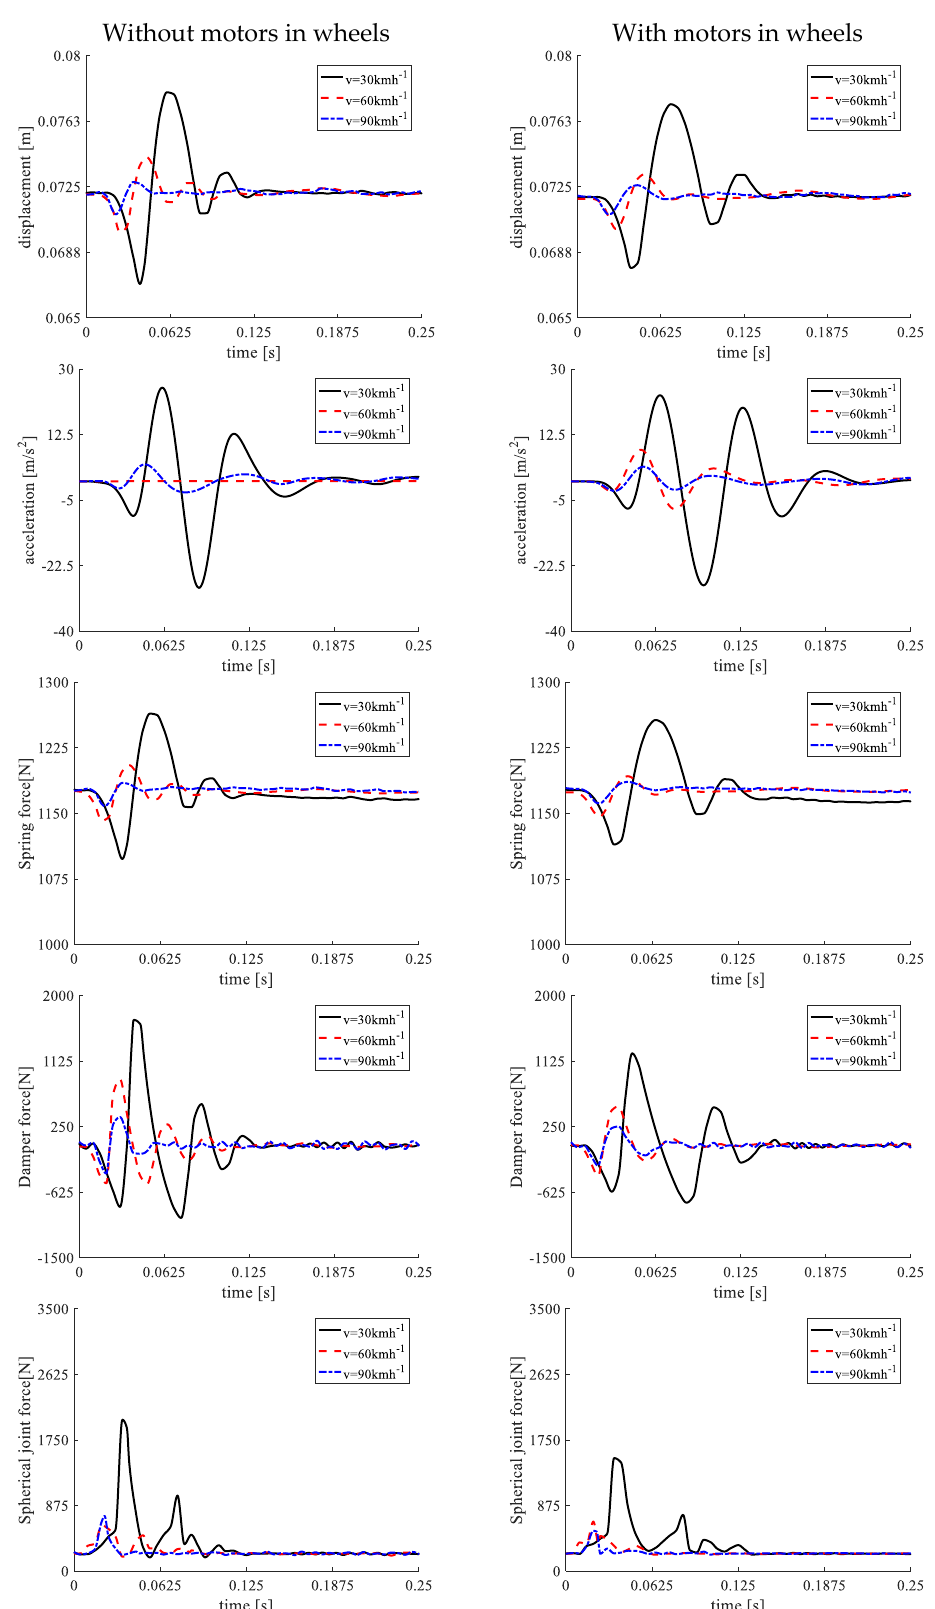
Figure 11. Selected time courses obtained for the suspension model with the rigid beam during overcoming the U-type obstacle.